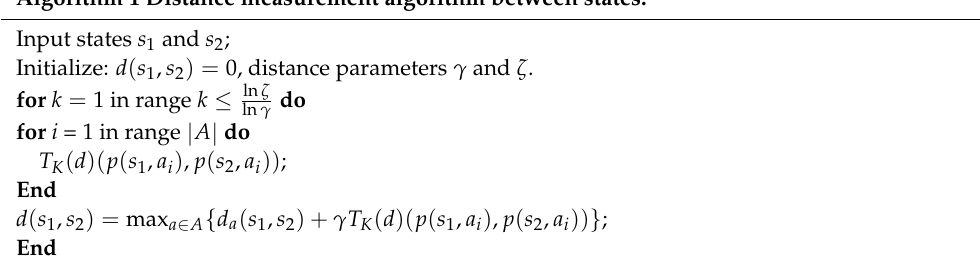
Algorithm 1 Distance measurement algorithm between